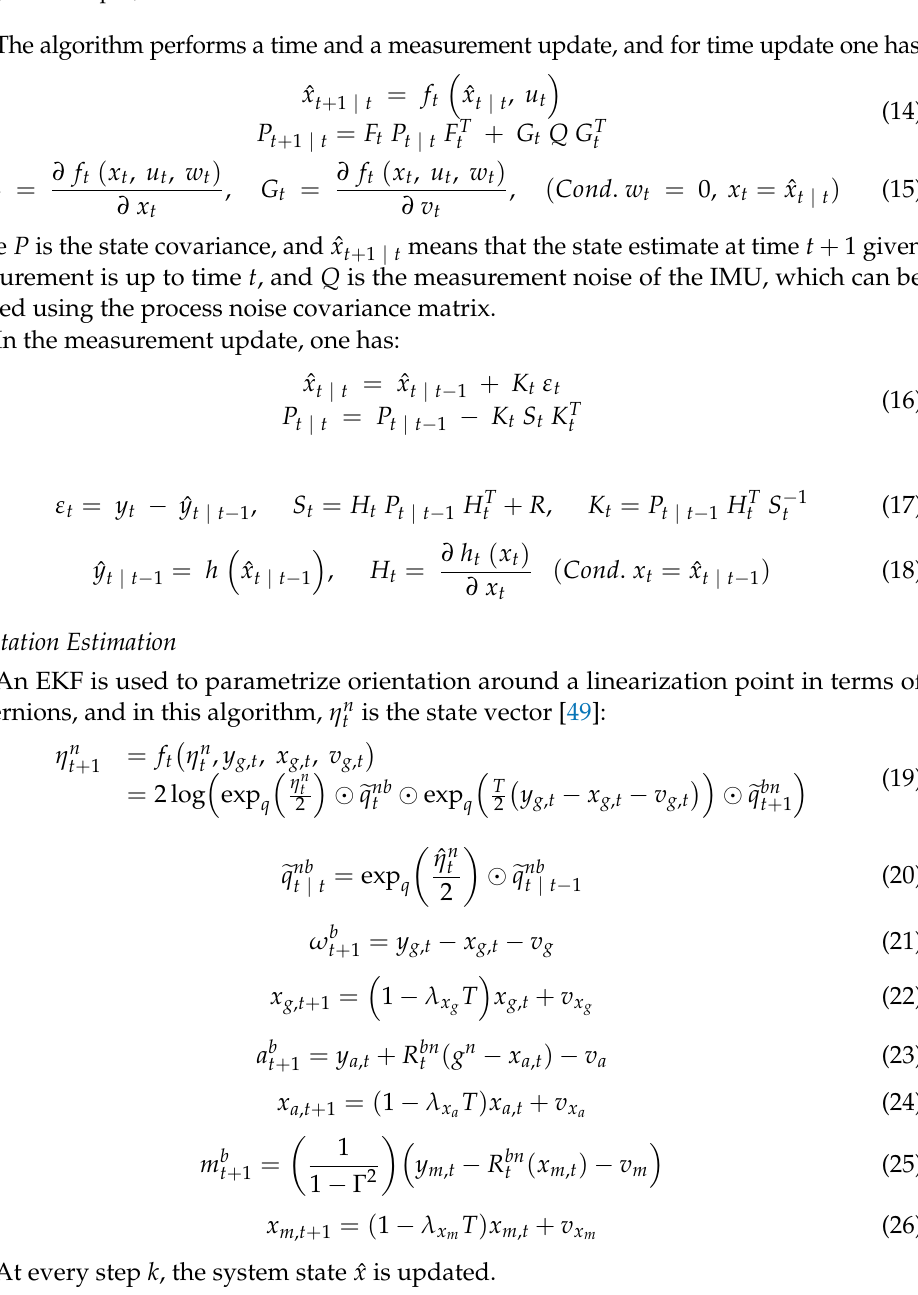
u is the control inputs, x the internal state i i